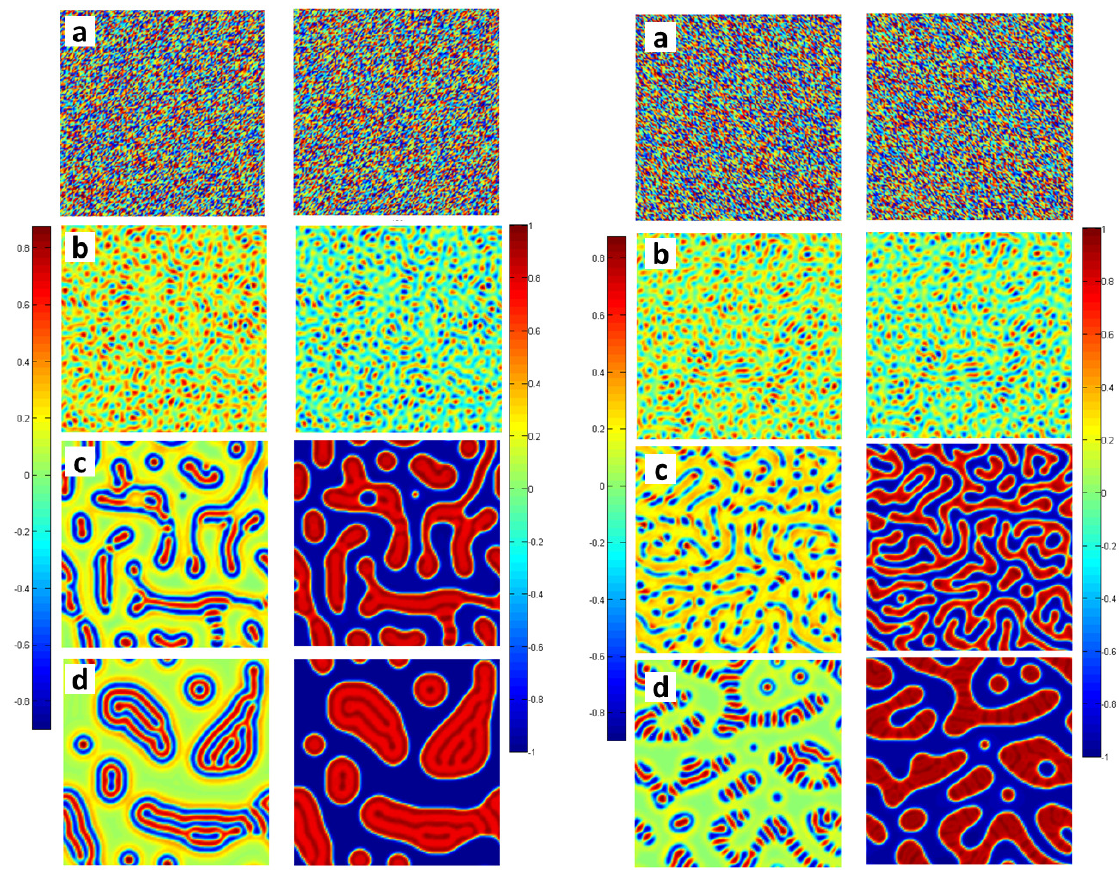
Figure 4: Time evolution of the copolymer-solvent sys- tem. The figures show the order parameter of copoly- mer φ on the left and the order parameter of solvent η on the right. Simulation data: system with a 512x512 grid with ∆ x = 0 . 5 , ∆ t = 1 . 5 and periodic boundary conditions for both order parameters. c 2 = 0 . 1 , u 2 = 1 , D 2 = 1 , α = 1 , φ = 0 was used for the copolymer. For this set of parameters the structure corresponds to a lamellae structure. c 1 = 0 . 3 , u 1 = 1 , D 1 = 0 . 5 was used for the solvent. The interaction parameters were b 1 = 0 . 07 , b 2 = 0 . 3 , b 3 = 0 , b 4 = 0 . 1. Times: (a) t = 0, (b) t = 10, (c) t = 1000, (d) t = 10000.